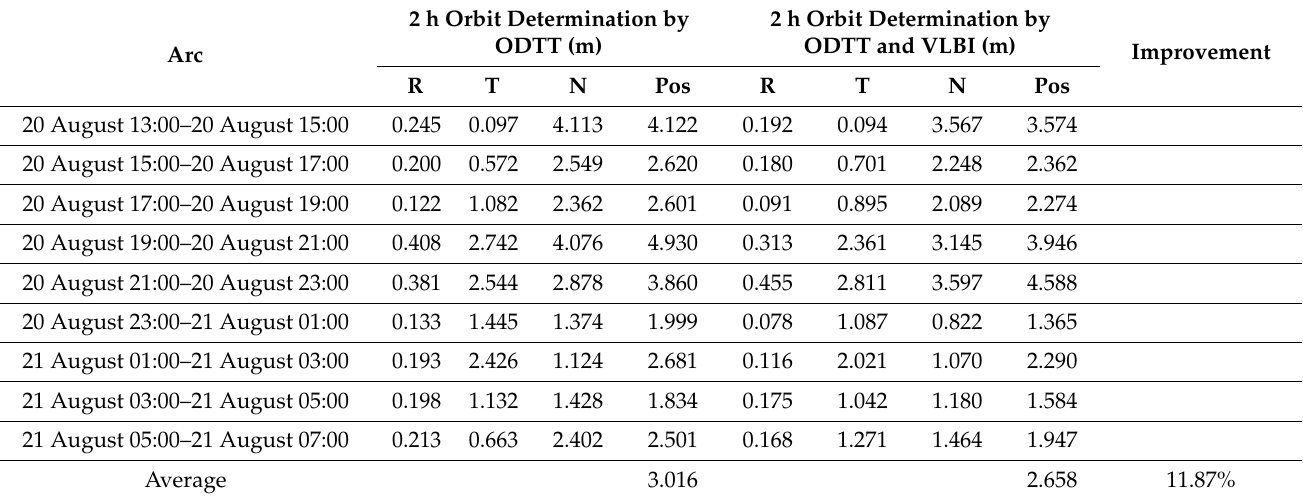
Table 4. The results of the bias with arcs of 2 h.